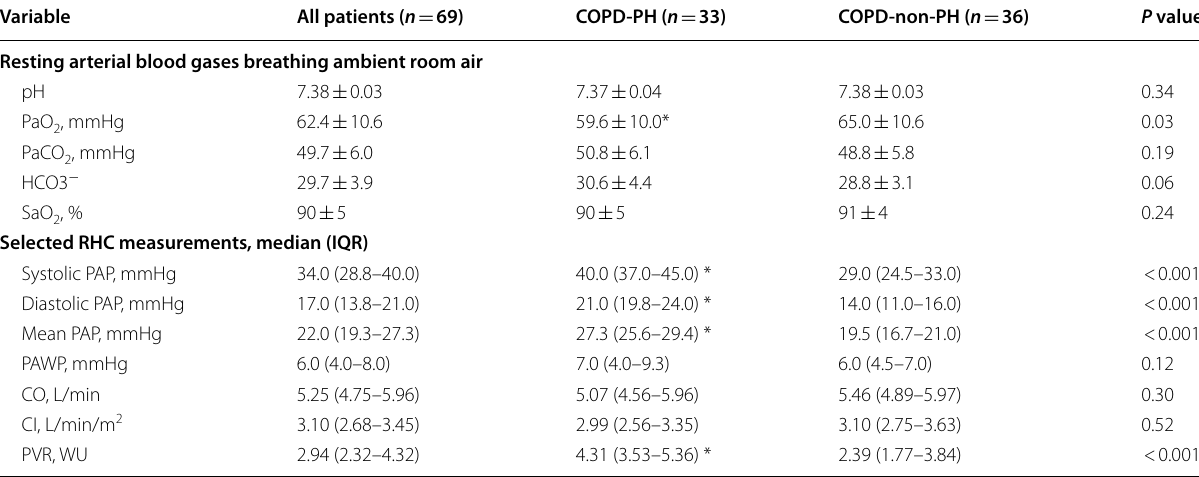
Values are means SD unless otherwise specified. * P < 0.05 COPD-PH patients vs. COPD-non-PH ± CI Cardiac index, CO Cardiac output, COPD Chronic obstructive pulmonary disease, HCO3 − bicarbonate, IQR Interquartile range, PaCO 2 Partial pressure of arterial carbon dioxide, PaO 2 Partial pressure of arterial oxygen, PAP Pulmonary artery pressure, PAWP Pulmonary artery wedge pressure, PH Pulmonary hypertension, PVR Pulmonary vascular resistance, RHC Right heart catheterization, SaO 2 arterial hemoglobin oxygen saturation, WU wood units